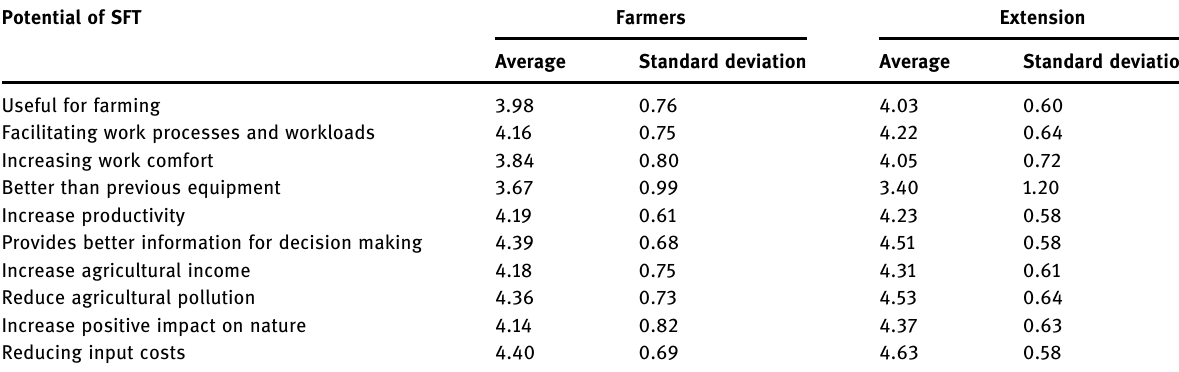
Table 3: The value of the perceived power of farmers and extension workers on the potential of SFT Potential of SFT